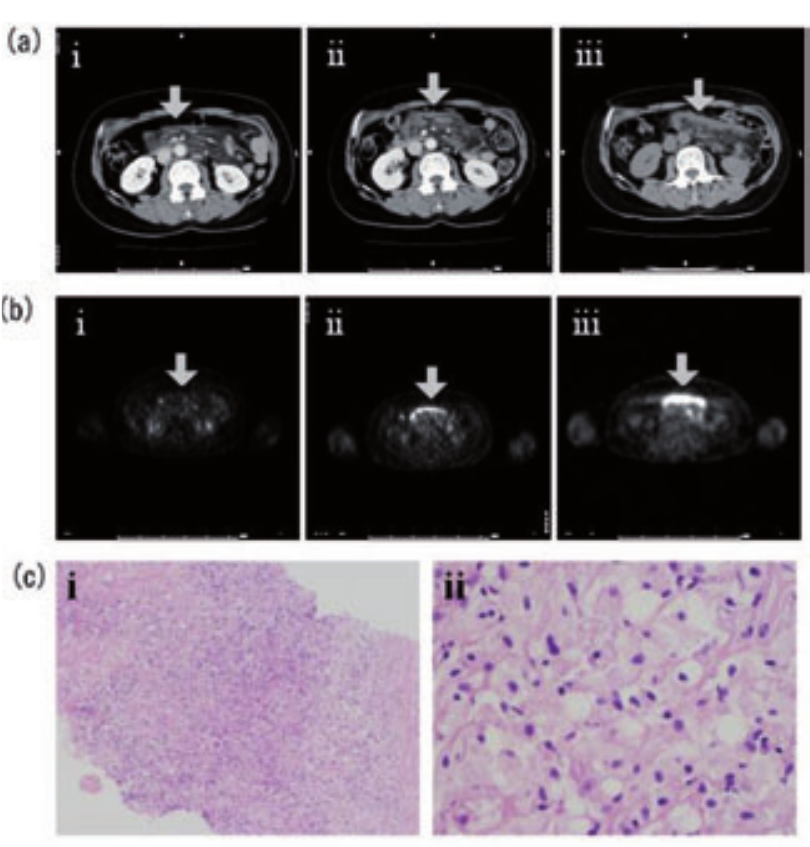
Figure 1. Imaging and pathologic evaluation of mesenteric panniculitis. During treat- ment and before SCT, we evaluated the clinical course of the mesenteric mass by CT (A) and 18F-FDG-PET (B). (A) Clinical course of mesenteric lesion evaluated by CT imag- ing. Mesenteric hypertrophy before treatment reduced during chemotherapy (i), after sal- vage chemotherapy (ii), and before PBSCT (iii). Arrows indicate hypertrophic mesenteri- um. (B) Clinical course of mesenteric lesion evaluated by FDG-PET. An accumulation positioned at the mesenterium detected by FDG-PET (i) was more intensified after sal- vage chemotherapy (ii) and did not improve before PBSCT (iii). Arrows indicate an increased accumulation in accordance with the enlarged mesenterium. (C) Pathological findings of biopsied mesenteric mass. Fatty necrosis surrounded by foamy macrophages and reactive lymph adenopathy was characteristic of the mesenterium. Immunohistological staining failed to detect CD20, CD10, CD79a, and bcl-2, with no indications of malignant lymphoma: (i) H-E stain (x 400), (ii) H-E stain (x